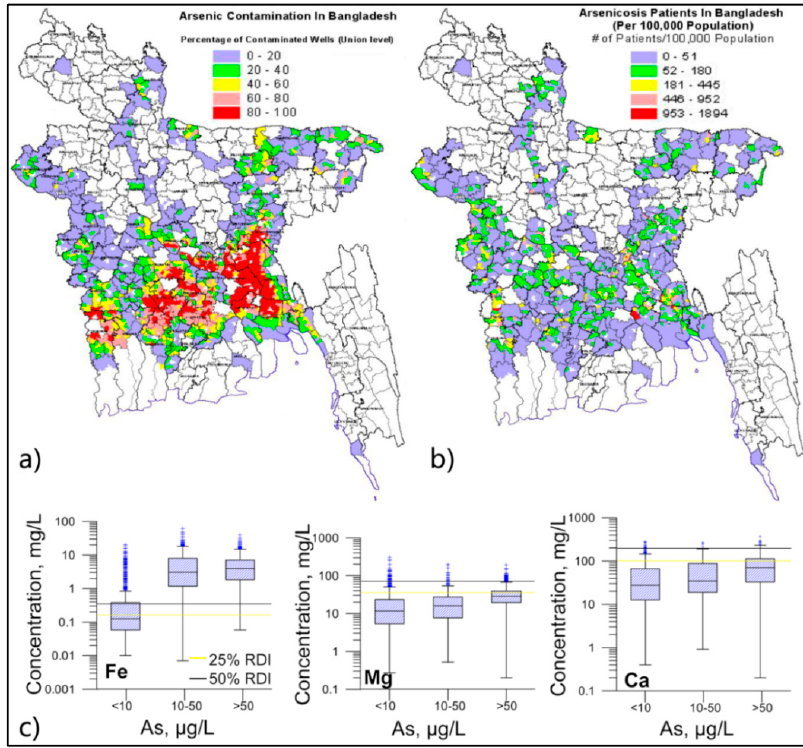
Figure 11. Spatial variation of well water concentration of As and arsenicosis patients in Bangladesh [67]. ( a ) Percentage of tubewells contain As concentration, above 50 µg/L—Bangladesh standard for drinking water As, at union level; and ( b ) distribution of arsenicosis patients in Bangladesh. The patients’ data have a number of limitations, in particular the influence of beneficial mineral nutrients on patients is not known; ( c ) High arsenic wells in Bangladesh indicate higher concentrations of Fe, Mg and Ca.